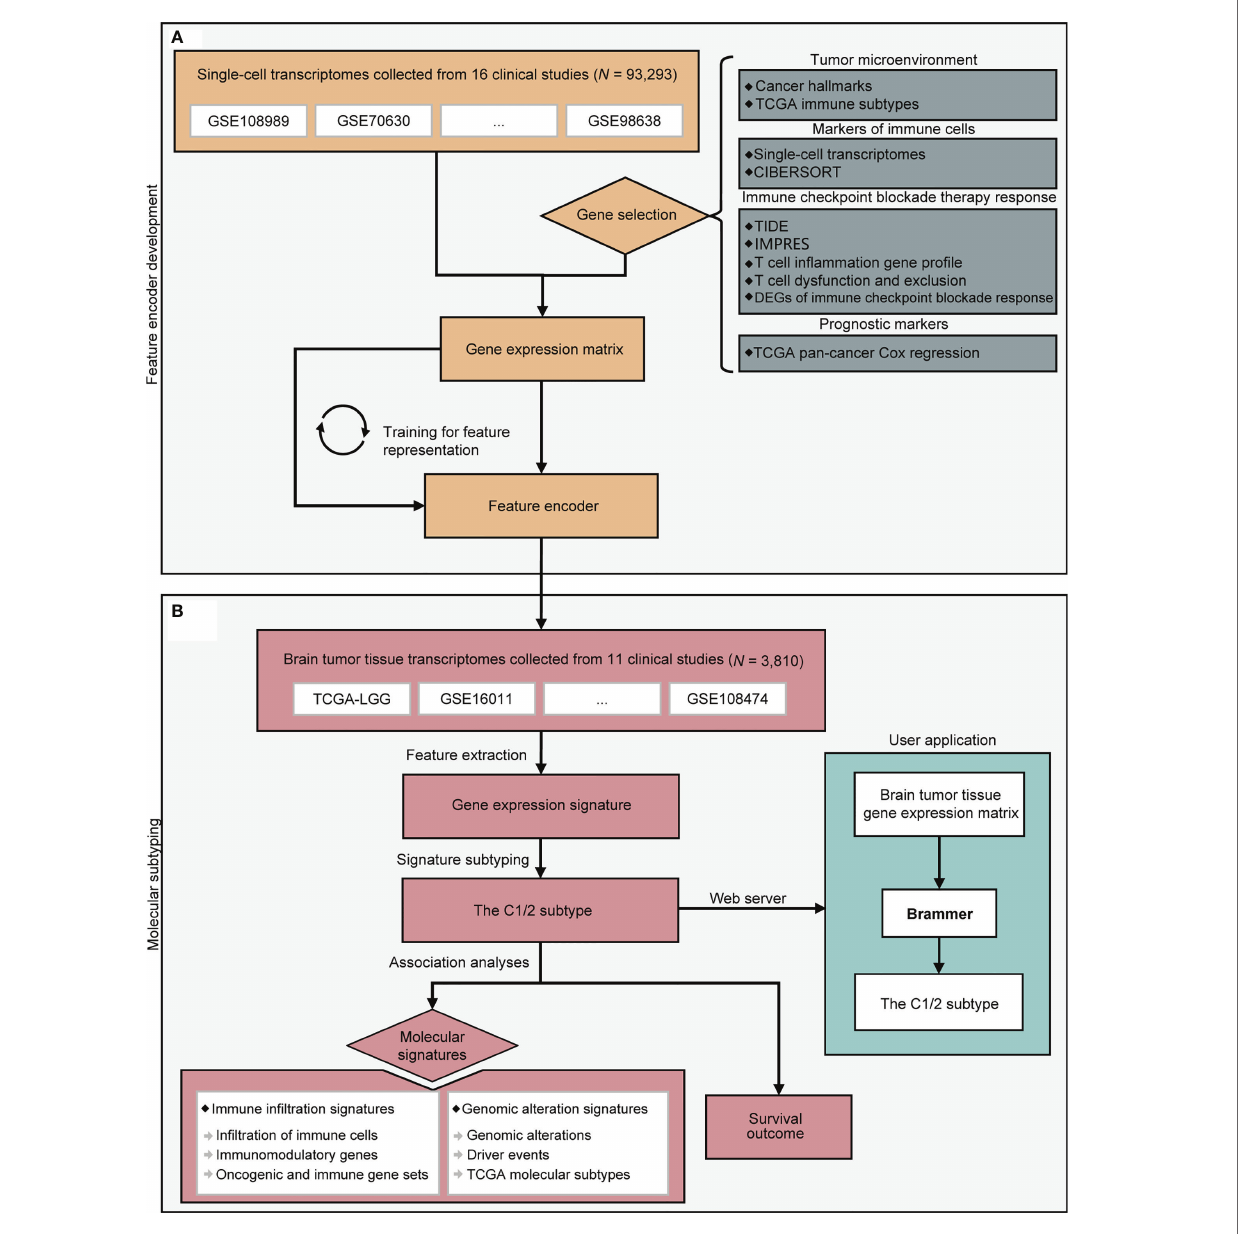
FIGURE 1 | A fl owchart depicting all procedures conducted in this study. The upper panel (A) describes the steps involved in the development of a deep learning model to learn feature representation from single-cell transcriptomes. The lower panel (B) depicts molecular subtyping of brain tumors and downstream analysis tasks. CIBERSORT, TIDE, and IMPRES were referenced from (22, 25, 26). DEG, differentially expressed gene; TCGA, the Cancer Genome